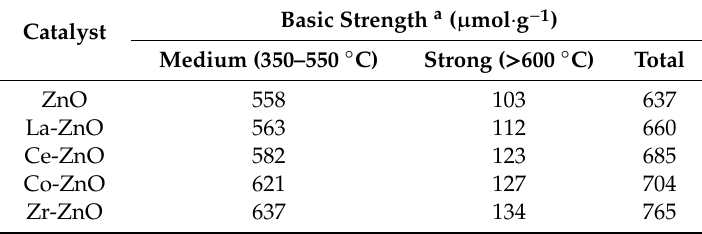
Figure 2. CO 2 -TPD profiles for transition metal-modified ZnO. Table 1. Basic strength of transition metal-modified ZnO from CO 2 -TPD profiles.